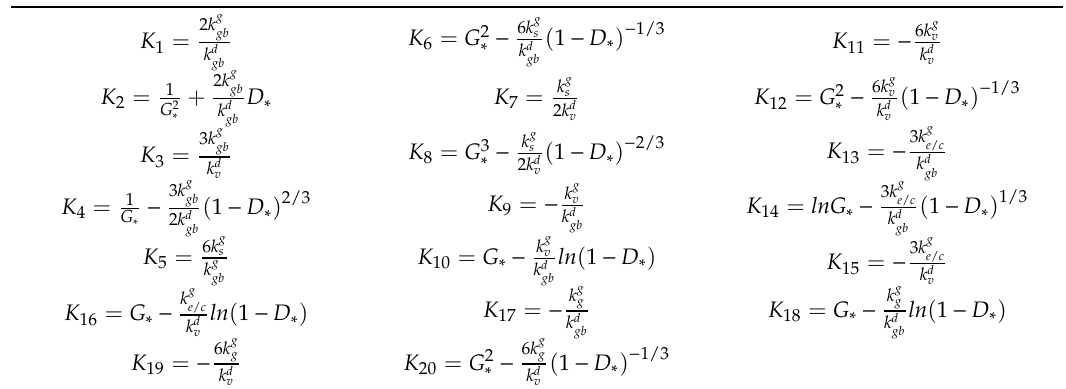
Table 2. Grain size versus relative density relationships, integration